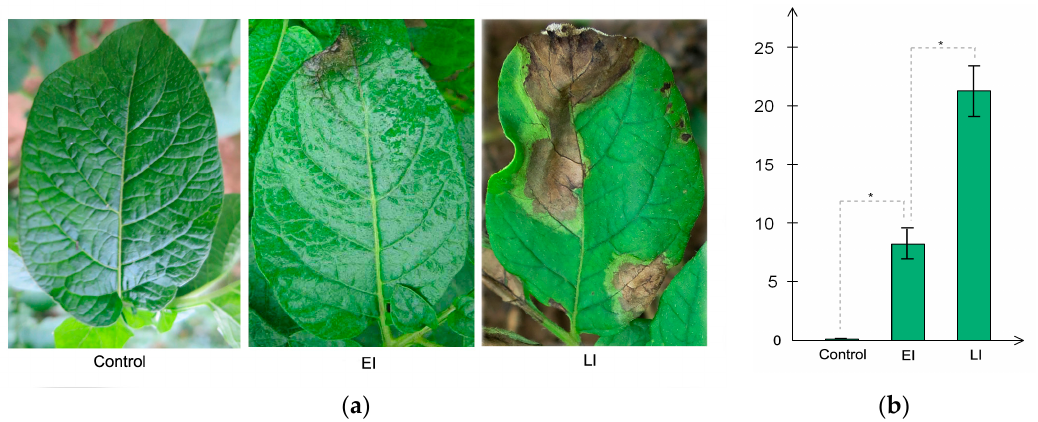
Figure 1. Phenotypic observation of the three time-points. Control corresponds to time-point 0 Hours post inoculation, EI corresponds to 48 hpi, and LI corresponds to 120 hpi. ( a ) Sizes of lesions induced by the P. infestans zoospores at different exposure times. The diameter of each lesion was measured at 2 and 5 days after inoculation ( b ). Three replicates were used for each treatment in these tests. Bars represent the standard deviation of three replicates. Statistical significance was analyzed using Student’s t -test. The asterisk indicates the significant difference (* p < 0.05).